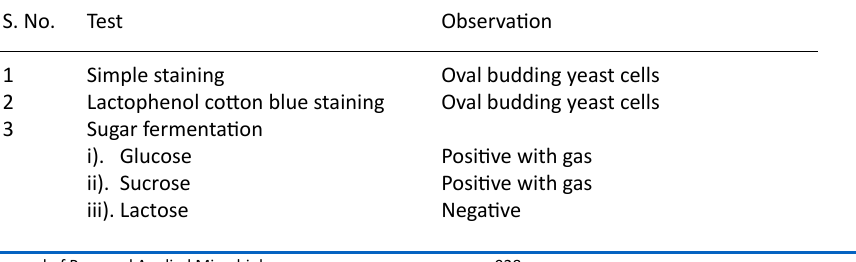
Table 1. Morphological and sugar fermentation characteristics of Meyerozyma sp. VITPCT75 S.